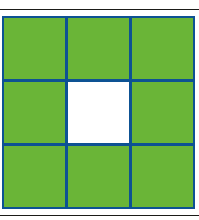
Figure 3: A rectangle (square) with a square window [29].